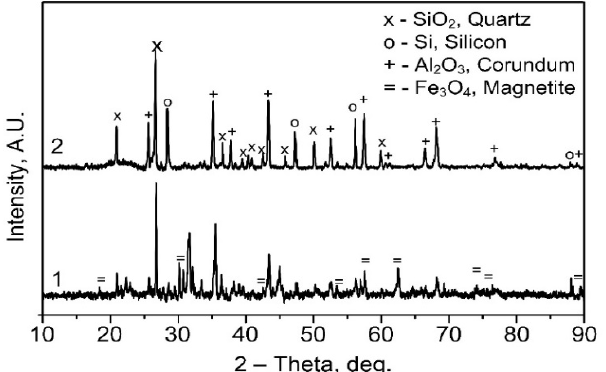
Figure 6. XRD patterns: 1—raw material fraction [A]; 2—solid residue after chemical leaching of a raw material fraction [A].